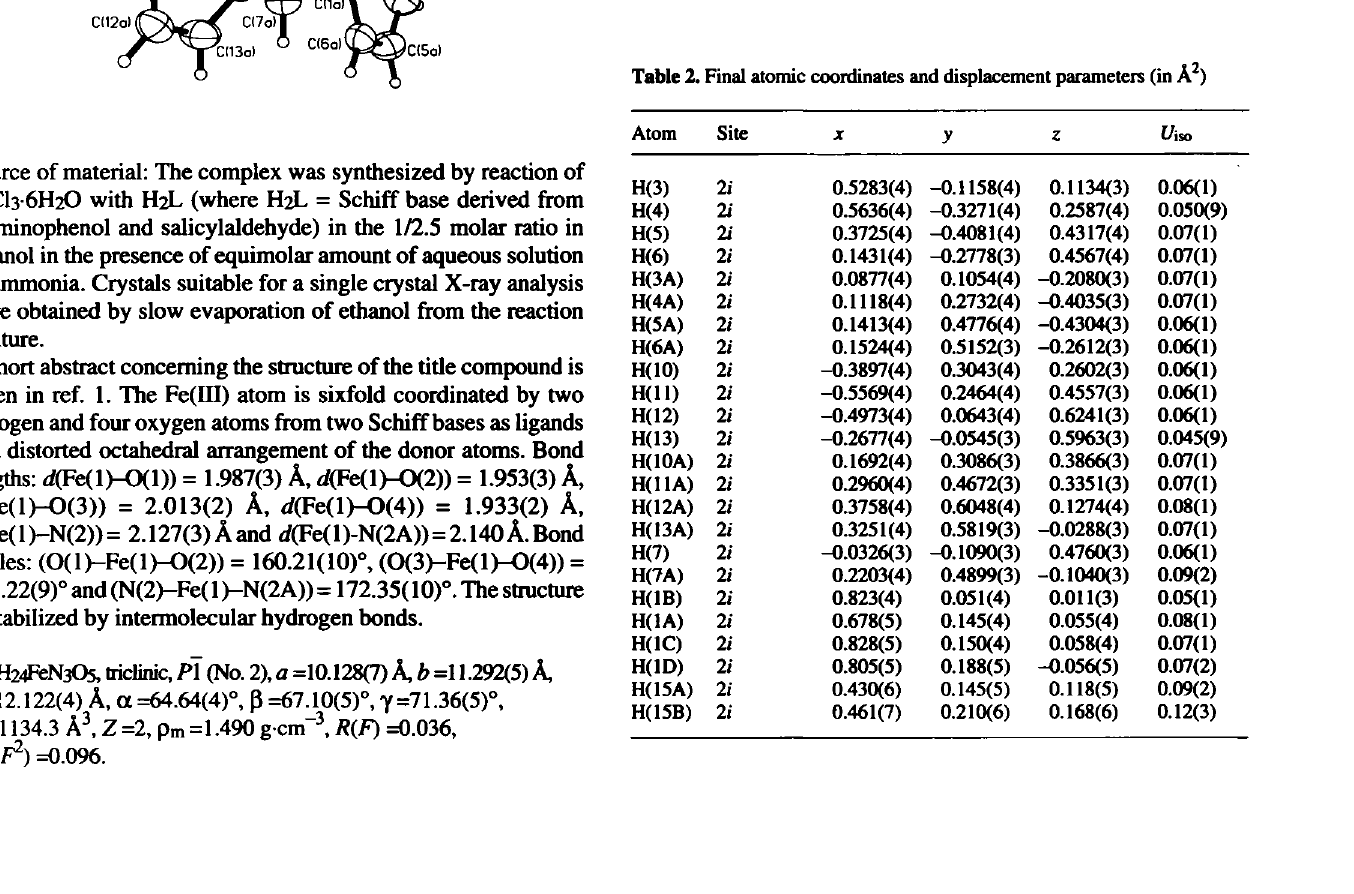
Table 2. Final atomic coordinates and displacement parameters (in Â 2